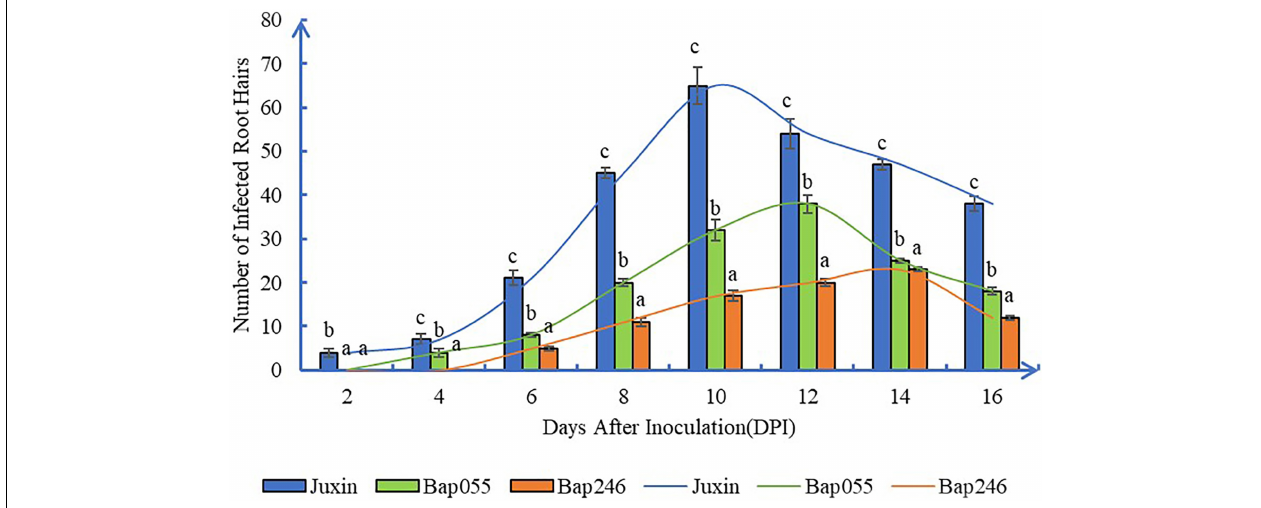
FIGURE 4 | Root hair infection rate in three Chinese cabbage genotypes at different time-point after inoculation of P. brassicae . The curves showed similar infection rate trends in the three hosts, at first increased, and then decreased overtime. Data are mean ± SE. Different letters on the same color bars indicate significant difference at P < 0.05 level by LSD test.